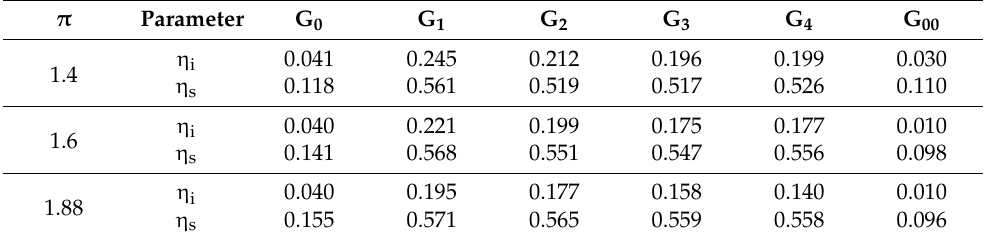
Table 2. Efficiency for individual gaps for 10,000 rpm obtained from two methods. π